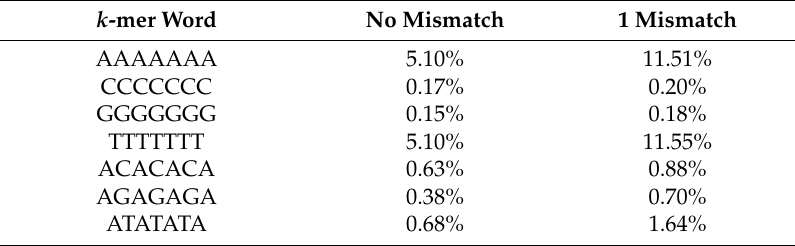
Table 7. Correlation contributions for correlations between introns and intergenic regions for tandem repeat k -mer words with repeat unit length ≤ 2 bp for either no or one allowed mismatches, for k = 7 (top) and k = 11